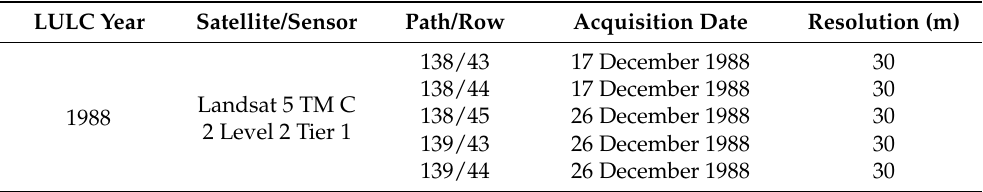
Table 1. Details of the dataset